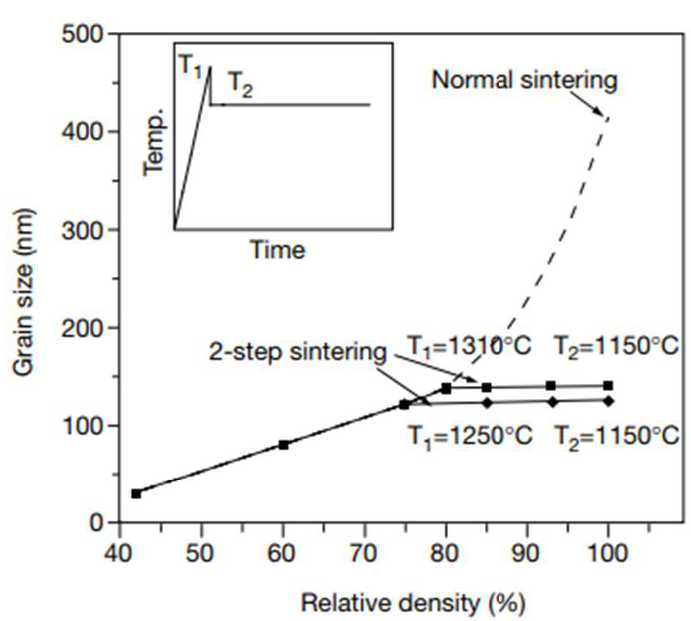
Figure 6. Microstructural evolution during two-step sintering of Y 2 O 3 [28]. The inset shows a schematic of the thermal cycle in two-step sintering (reprinted with permission from Springer Nature) .